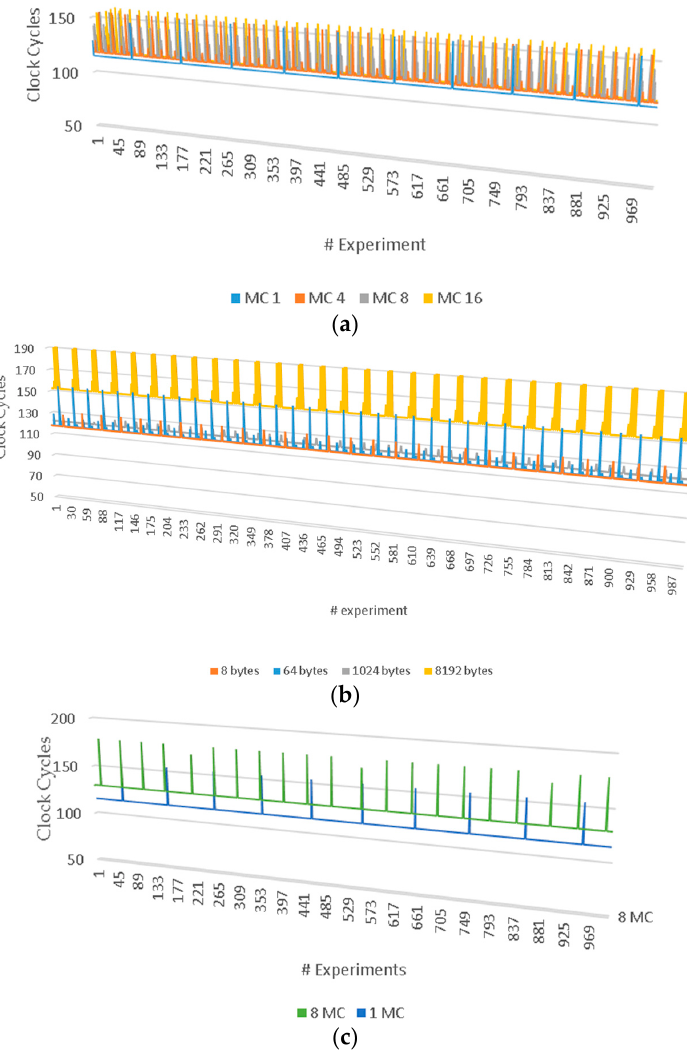
Figure 6. Latency measurements. ( a ) Addresses of the data read are offset between 8–64 bytes; ( b ) The requested data are in other DIMMs and served by a different MC port; ( c ) Addresses of the data read are between 8–64 bytes and the number of MC ports changes 1 to 8.